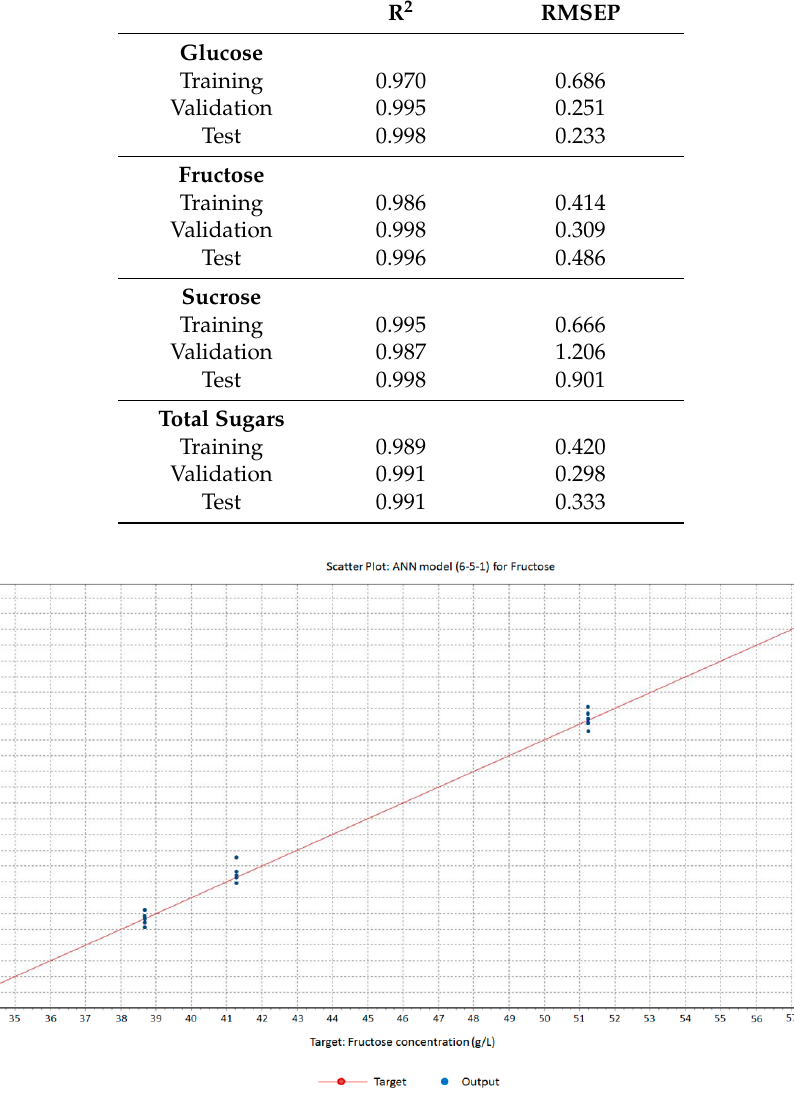
Figure 5. Scatter plot showing the relationship between analyzed (HPAEC-PAD) and predicted